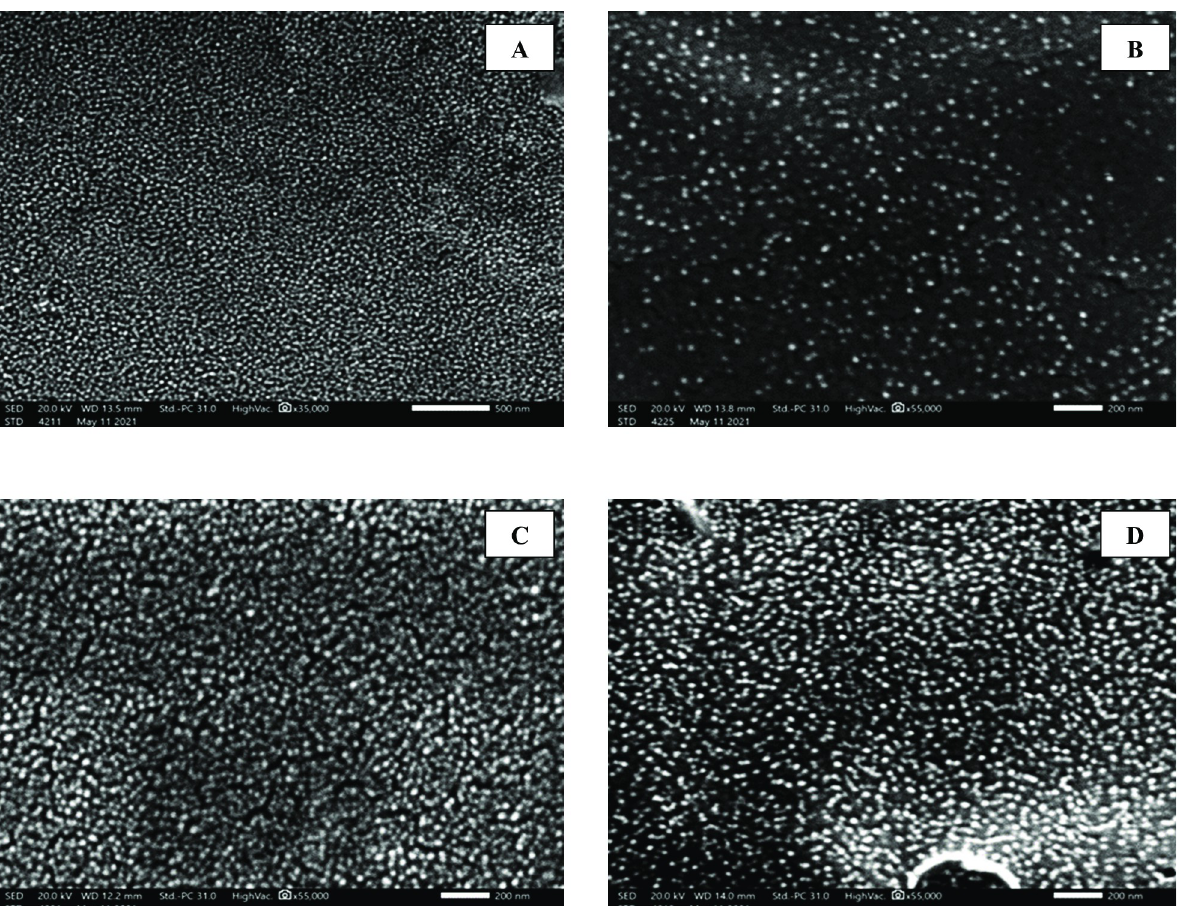
Fig 2. SEM micrographs of the prepared NPs showing regular, smooth and spherical shape. (A) CS/Alg NPs (X 35,000). (B) Spiramycin loaded CS/Alg NPs (X 55,000). (C) Propolis loaded CS/Alg NPs (X 55,000). (D) Spiramycin/propolis loaded CS/Alg NPs (X 55,000). food intake with better activity. Spiramycin/propolis loaded CS/Alg NPs treated subgroup appeared remarkably healthier than all other subgroups. II.2. Parasitological study. II . 2 . 1 . Survival time . The survival time was assessed for 30 days. Statistically, there was a high significant difference in mice survival between all groups (p < 0.001). As the tremendous difference is clearly shown in the mean survival time, the unin- fected mice had a mean time of 30.0 days, whereas infected untreated mice showed a mean time of 6.4 days. Regarding treated mice, they flaunted a mean survival time ranging between 7.6 and 19.8 days. The most extended survival time was observed among mice receiving spira- mycin/propolis loaded CS/Alg NPs. (Table 2 and Fig 4) II . 2 . 2 . Mortality rate (MR) on the 8 th day post-infection . On the eighth day post-infection, no mice died among the uninfected control while the MR was 100% in the infected untreated con- trol. The MR was 80% among both spiramycin and propolis treated subgroups. On the other hand, no mice died among all NPs treated subgroups including CS/Alg NPs, spiramycin loaded CS/Alg NPs, propolis loaded CS/Alg NPs and spiramycin/propolis loaded CS/Alg NPs. II . 2 . 3 . Parasite burden and percent reduction (%R) . Statistically, there was a high significant difference in parasite count between all groups (ANOVA test, p < 0.001). The mean